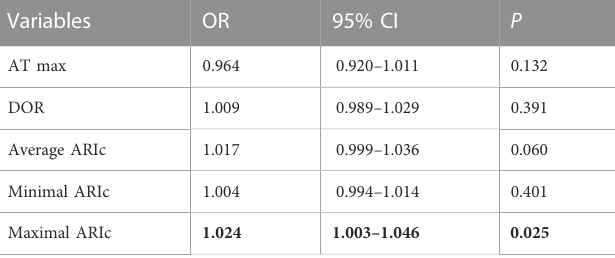
Statistically signi fi cant associations are in bold.